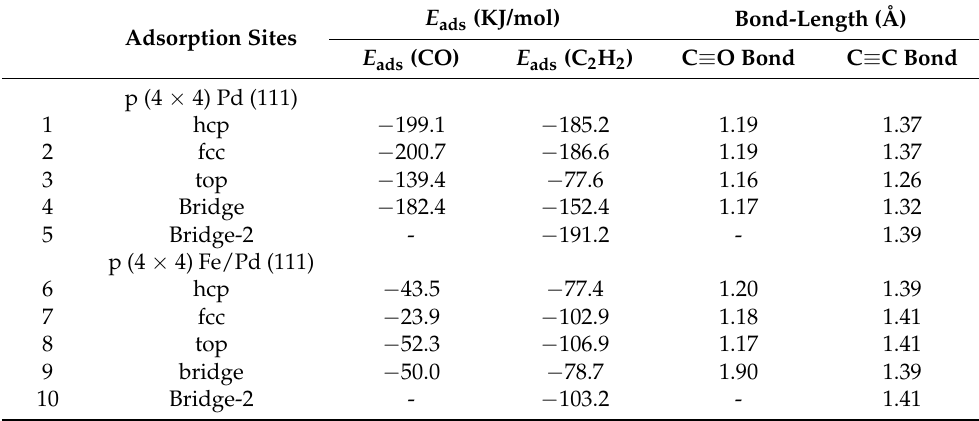
Table 3. The Calculated Binding Energies ( E ads ) of CO and C 2 H 2 on the surface of the sample, as well as the bond length C ≡ O of CO and C ≡ C bond of C 2 H 2 of adsorbate-containing